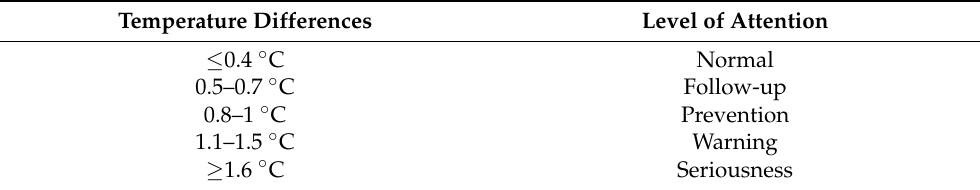
Table 1. Scale of the level of attention given according to differences of temperatures between the body ROI (body region of interest) against laterals or between two shots of the same